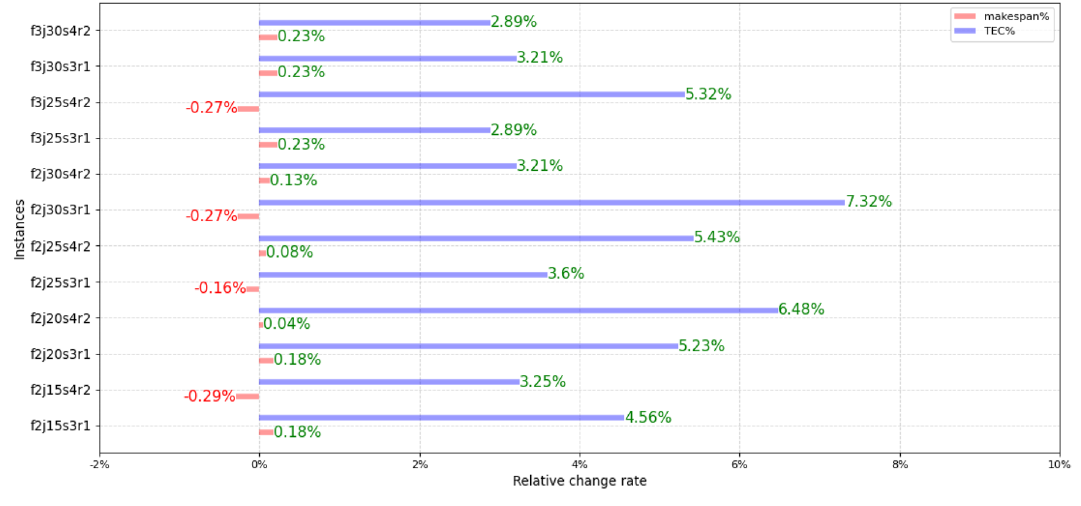
Figure 14. The relative change rate.